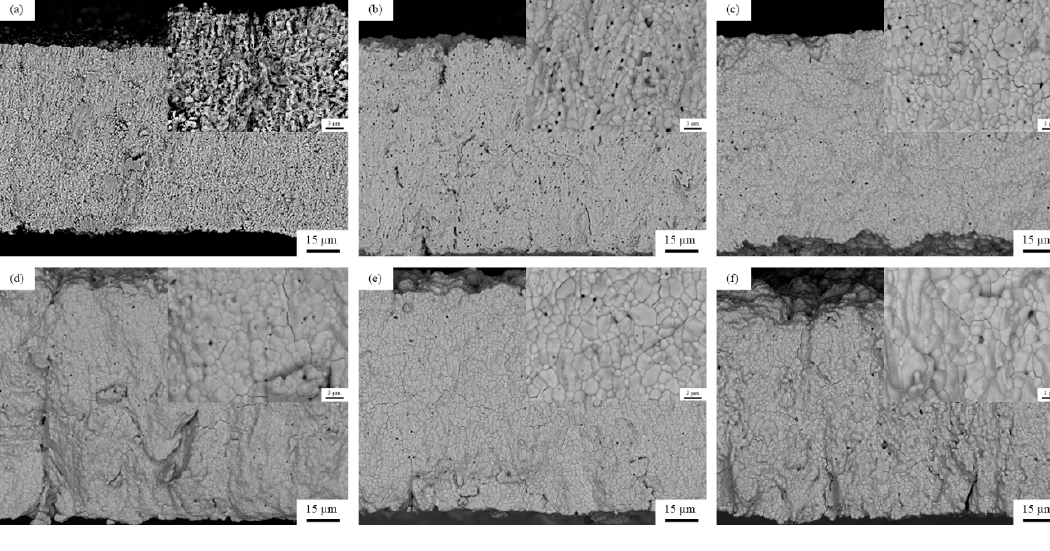
Figure 2. SEM images of fracture section of YSZ-1 coatings before and after thermal aging treatment in air at 1550 °C as a function of time: ( a ) as-sprayed; ( b ) 20 h; ( c ) 40 h; ( d ) 60 h; ( e ) 80 h; ( f ) 100 h.